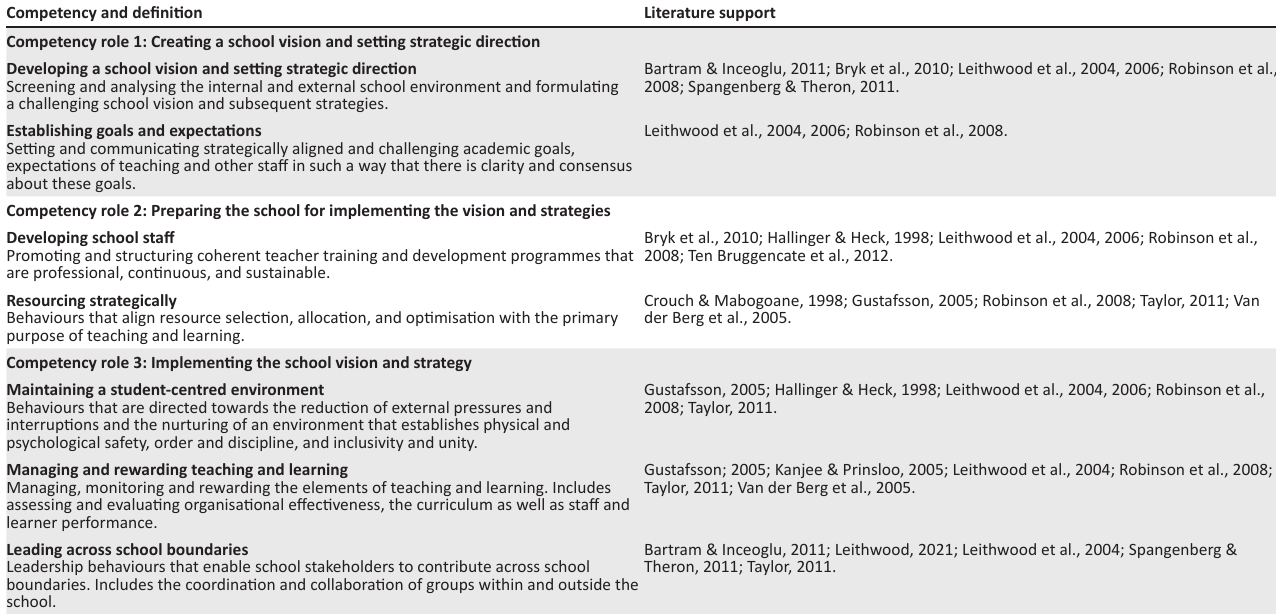
TABLE 1: Competency framework from literature